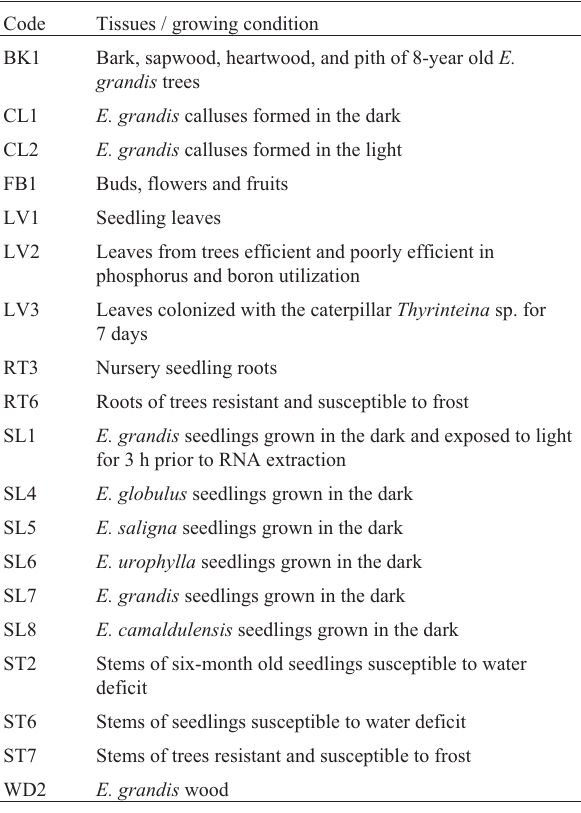
Table 1 - Codes and source tissues of cDNA libraries approved by the FORESTS